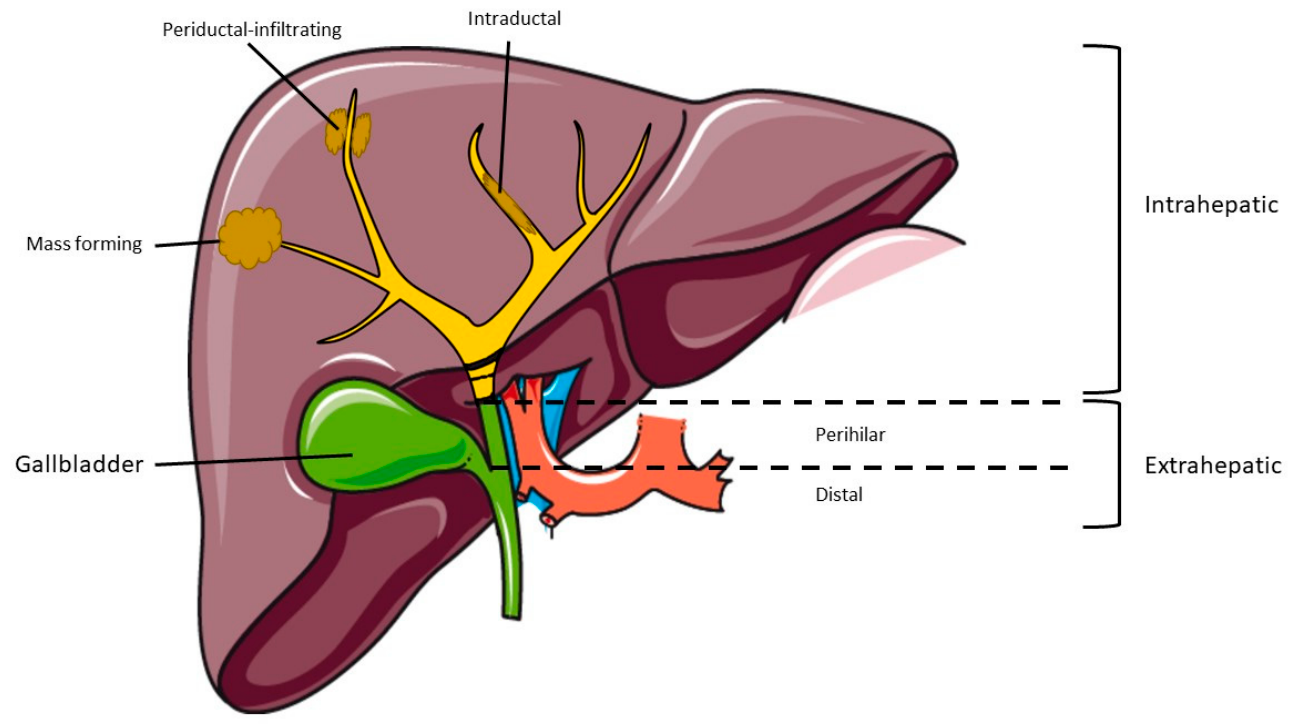
Figure 1. Classification of cholangiocarcinoma by anatomic location. Table 1. Major risk factors associated with the development of intrahepatic cholangiocarcinoma. Risk Factors for